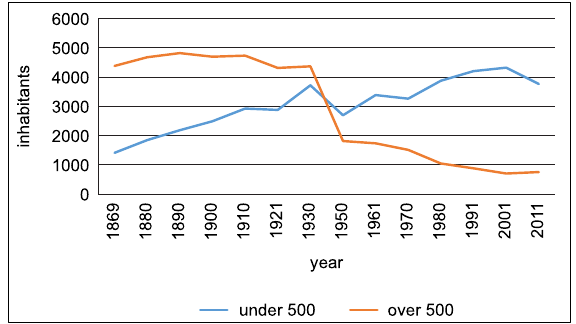
Fig. 7. Case of the Hanušovice micro-region (n Moravia): population development in settlements under (blue) and over (red) 500 m above the sea level 1869–2011. Source: Historický lexikon obcí